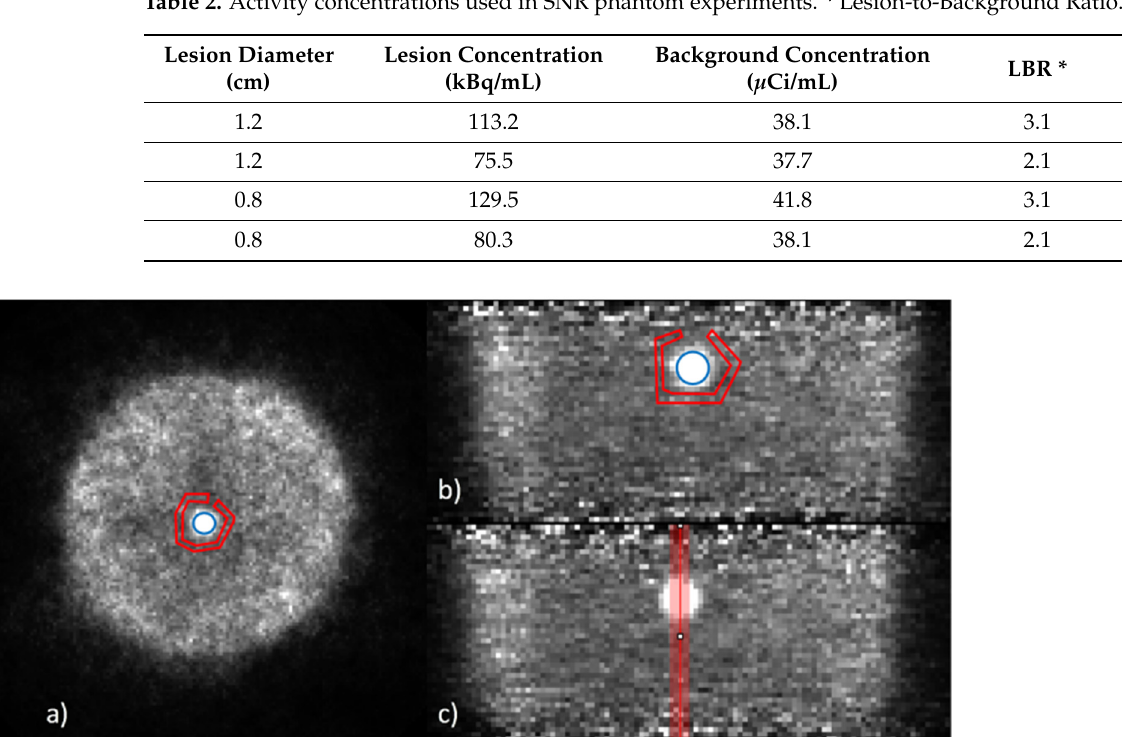
Figure 4. ROIs used to calculate the SNR. The average lesion voxel value is calculated from the ROI in blue in Figure ( a , b ), while the average background voxel value is calculated from the ROI in red. Figure ( c ) shows the profile used to measure the z-position of the lesion within the VoV.